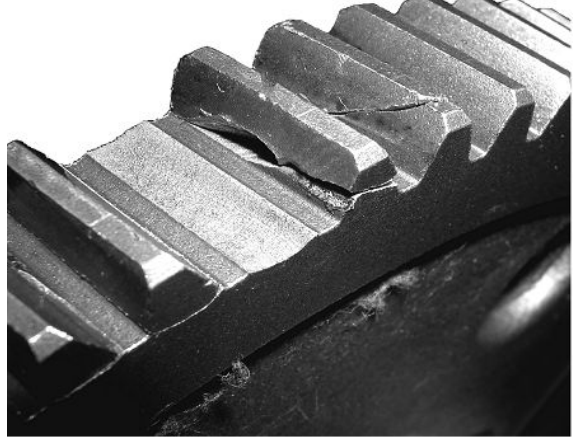
Fig. 1. Typical example of a tooth bending fatigue